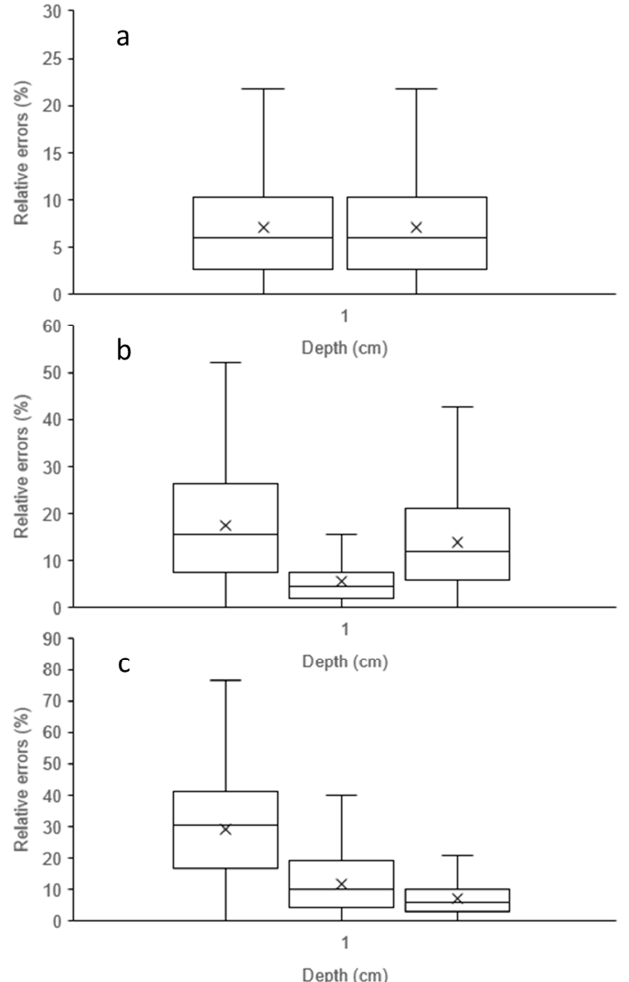
Figure 6. Box plots of relative errors of soil water content at different layers with average soil water content in planned wetted layers during different growing stages of winter wheat: ( a ) early stage; ( b ) middle stage; and ( c ) last stage. Y-axis indicates relative errors between the average value of soil water ( b ) middle stage; and ( c ) last stage. Y -axis indicates relative errors between the average value of soil content at 0–40 cm and at different depths in the soil profile, x-axis indicates soil water content at 10 water content at 0–40 cm and at different depths in the soil profile, X -axis indicates soil water content and 30 cm in (a). Y-axis indicates average value of soil water content at 0–60 cm, x-axis indicates soil at 10 and 30 cm in ( a ). Y -axis indicates average value of soil water content at 0–60 cm, X -axis indicates water content at 10, 30, and 50 cm in (b). Y-axis indicates average value of soil water content at 0–100 soil water content at 10, 30, and 50 cm in ( b ). Y -axis indicates average value of soil water content at cm, x-axis indicates soil water content at 10, 30, and 50 cm in (c). 0–100 cm, X -axis indicates soil water content at 10, 30, and 50 cm in ( c